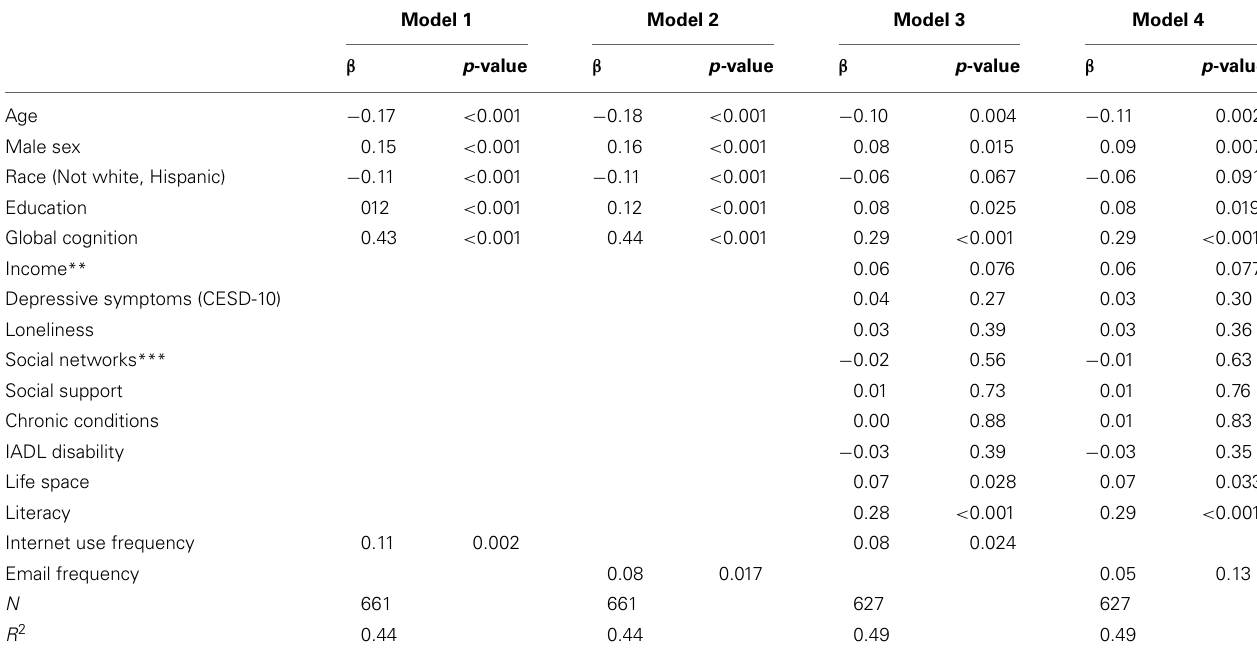
Table 3 | Associations of the frequency of internet and email use (independent variables) with financial and healthcare decision-making ability (dependent variable) *